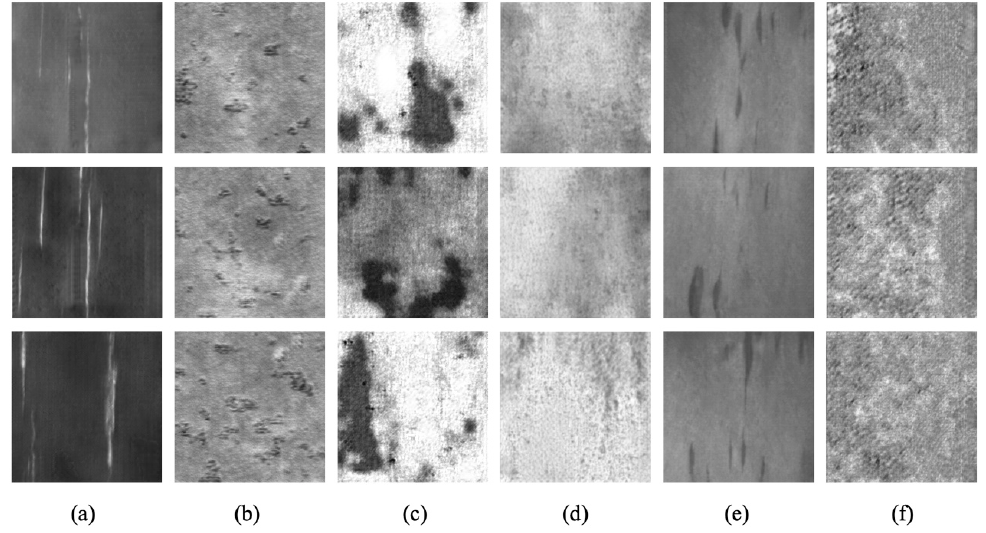
Figure 6. Examples of defect samples generated by EDCGAN. ( a ) Sc. ( b ) Rs. ( c ) Pa. ( d ) Ps. ( e ) In. ( f ) Cr.